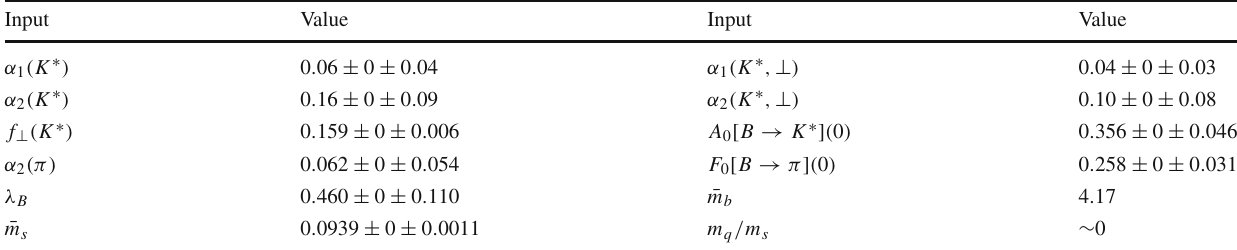
quantities are in GeV. The ± 0 in second position means that all uncer- tainties are considered as coming from a theoretical origin and they are treated according to the Rfit approach. See the text for references